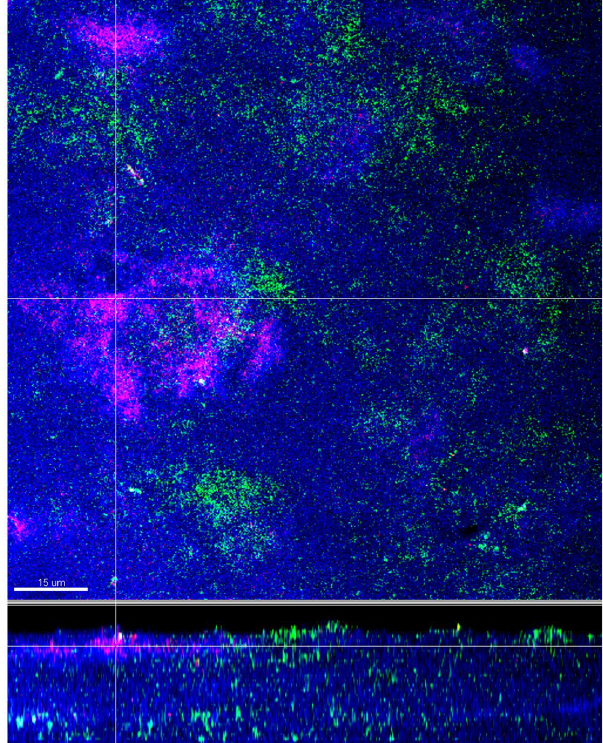
Figure 1. Localisation of A. geminatus within the biofilms. Confocal laser scanning microscopy images of fluorescence in situ hybridization (FISH) -stained 11-species biofilm. Bacteria appear blue due to DNA-staining using Syto 59. Due to FISH staining A. geminatus and V. dispar appear red and green, respectively. The biofilm base in the cross-sections is directed towards the top view. Scale bar: 15 µ